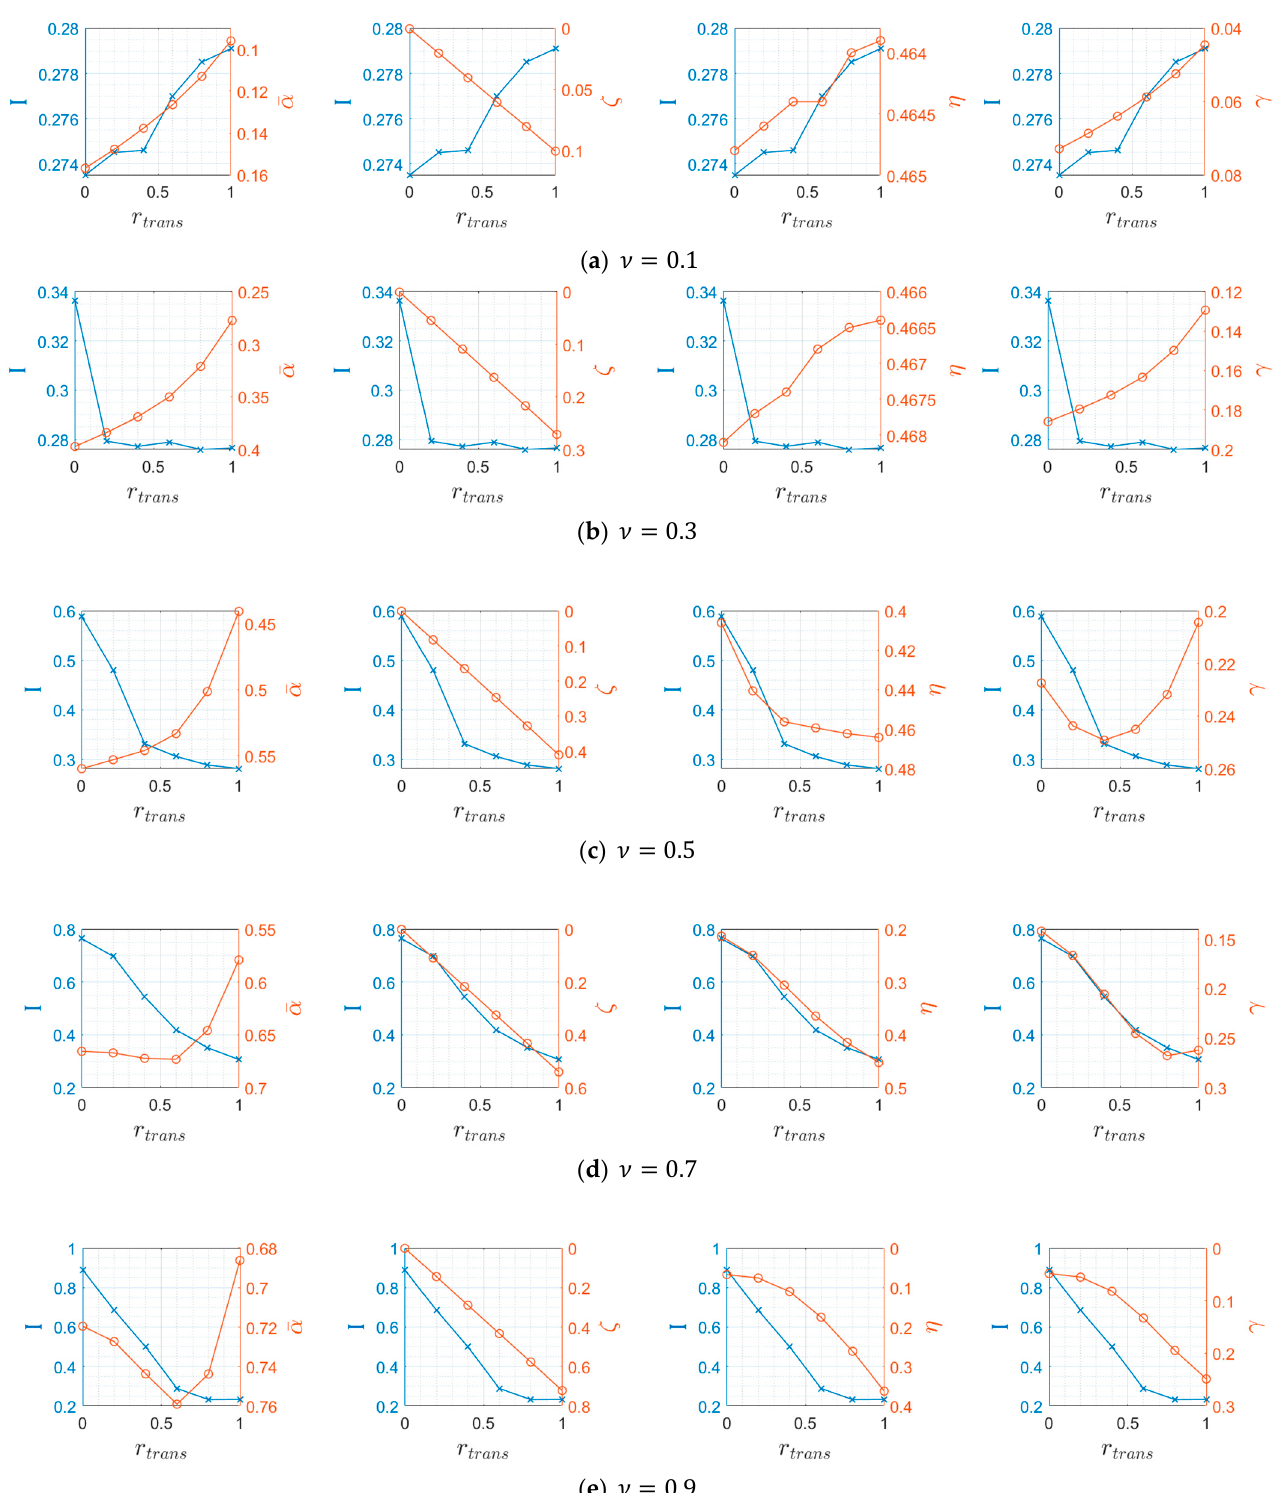
Figure 9. Comparison between 𝐼 (blue lines) and c-EIs (orange lines) with 𝜇 of 0.05. From the left, the indicators are streamline crossing, the relative rate of velocity change, mobility, and the product of streamline crossing and mobility. The intensity of segregation was calculated with the identical total time, equal to 10.